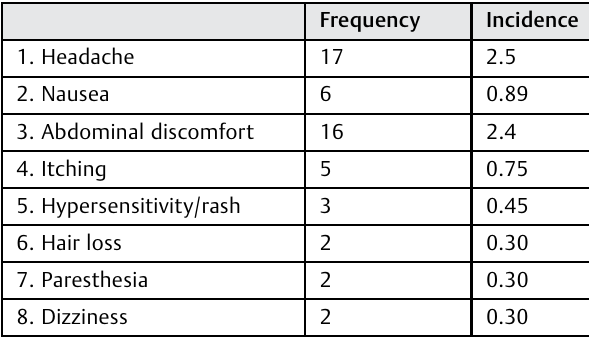
Table 6 VTE-related adverse events in the fi rst week according to initial treatment strategy